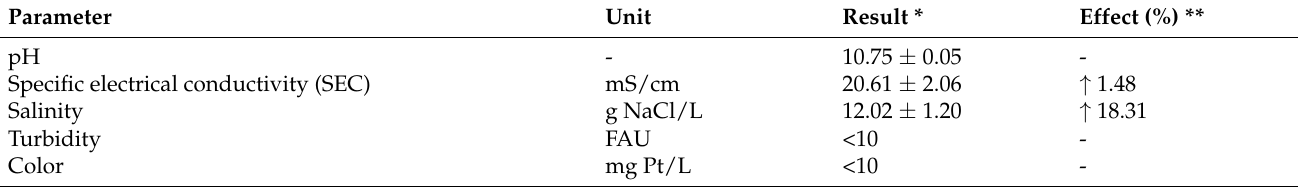
Table 9. Selected physicochemical parameters of treated galvanic wastewater after RSM application